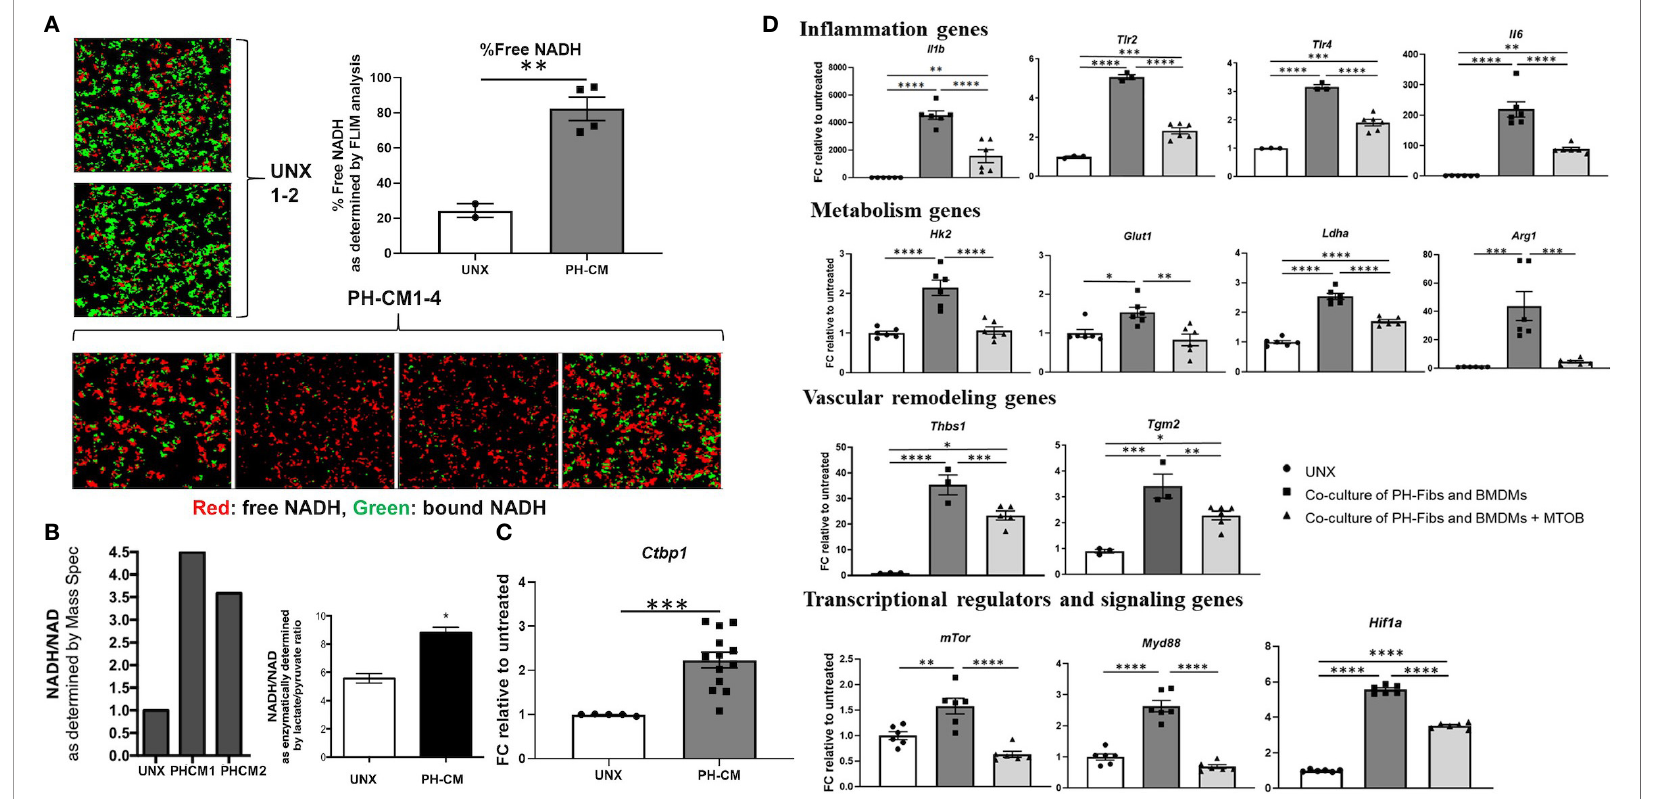
FIGURE 6 | PH- fi broblast conditioned media increased free NADH, as well as CtBP1 levels in BMDMs. MTOB, a small molecule inhibitor of CtBP1, inhibited gene activation in BMDMs in a fi broblast-macrophage co-culture system. (A) Fluorescence lifetime imaging (FLIM) of two-photon excited NADH was performed to directly visualize free-NADH (red: arbitrarily colored shorter excitation lifetime, free-NADH. Green: bound- NADH, longer excitation lifetime). A signi fi cantly increased detection of free-NADH was seen in PH-CM treated BMDM compared to untreated BMDMs. Data is represented as percentage of red signal and shown as mean ± sem. ** p < 0.01 compared to untreated BMDMs. (B) NADH/NAD + ratio was measured using Mass Spectrometry analysis and an enzymatic cycling reaction and represented by lactate/pyruvate ratio. * p < 0.05 compared to untreated BMDMs. (C) qPCR analysis showed signi fi cantly increased Ctbp1 levels in PH-CM treated compared to untreated BMDMs. Data is represented as fold change relative to untreated BMDMs and displayed as mean ± sem. *** p < 0.001. (D) Co-cultured PH-Fibs and BMDMs were treated with MTOB, a small molecule inhibitor of CtBP1. MTOB signi fi cantly decreased in fl ammatory genes Il1b, TLR2/4, IL6 , metabolic genes Glut1, Ldha, Hk2, Arg1 , vascular remodeling genes Tgm2, Thbs1 , and transcriptional regulators and signaling genes mTOR, MyD88, HIF1a in co-cultured BMDMs. Data is represented as fold change relative to untreated BMDMs, and displayed as mean ± sem. * P < 0.05, ** P < 0.01, *** P < 0.001, **** P <